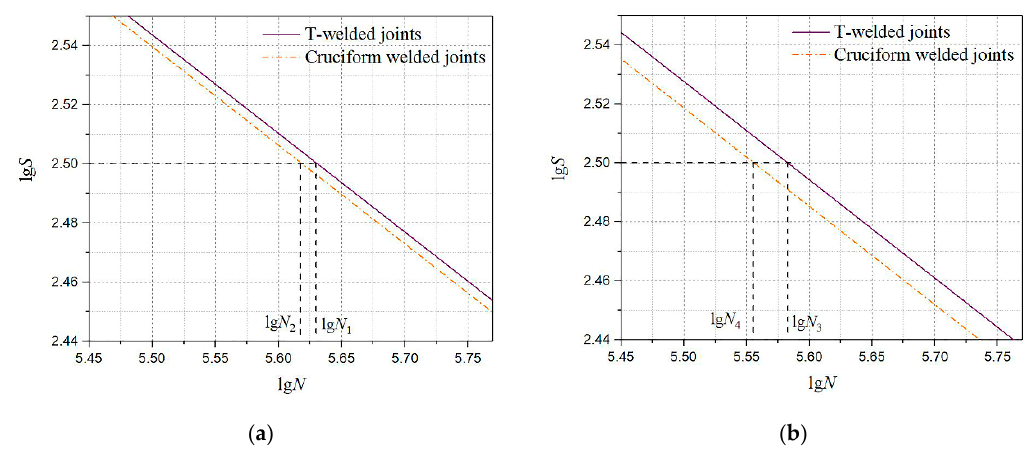
Figure 10. S–N curves of two welded joints at low temperature: ( a ) 50% confidence level and ( b ) 95% confidence level.